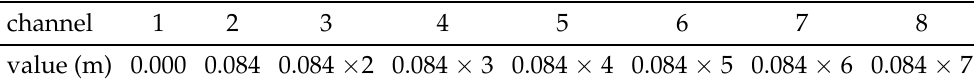
Table 1. Position of light source in the ground direction.